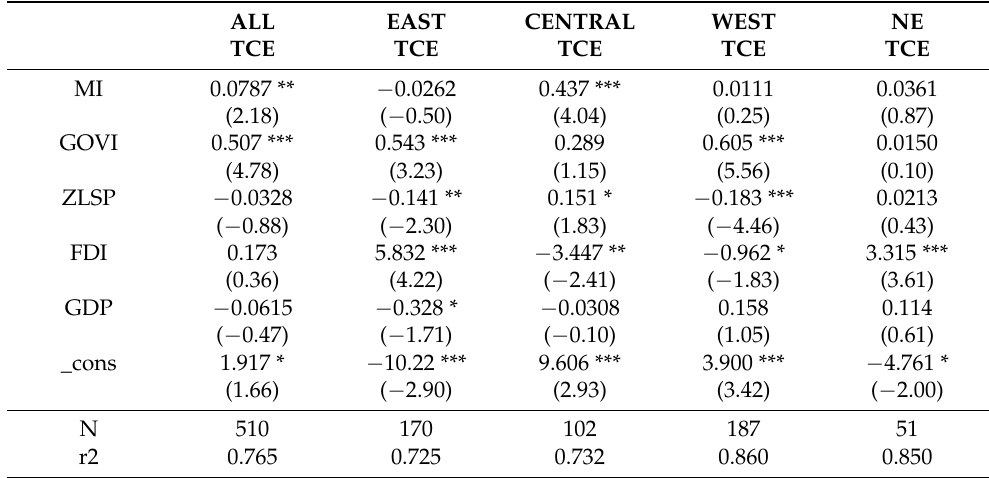
Table 1. Results of the benchmark